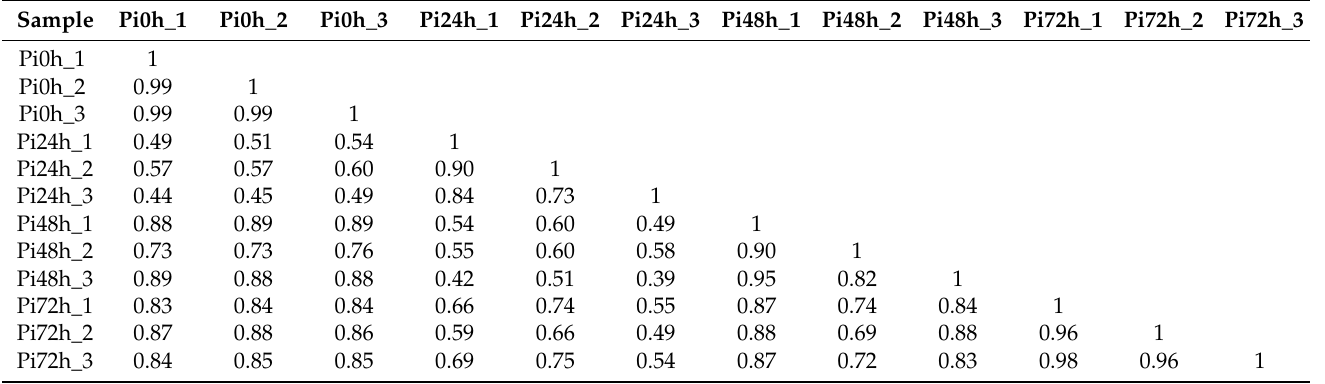
Table 3. Correlation coefficient between biological Table 2. The data quality analysis in the investigated samples.